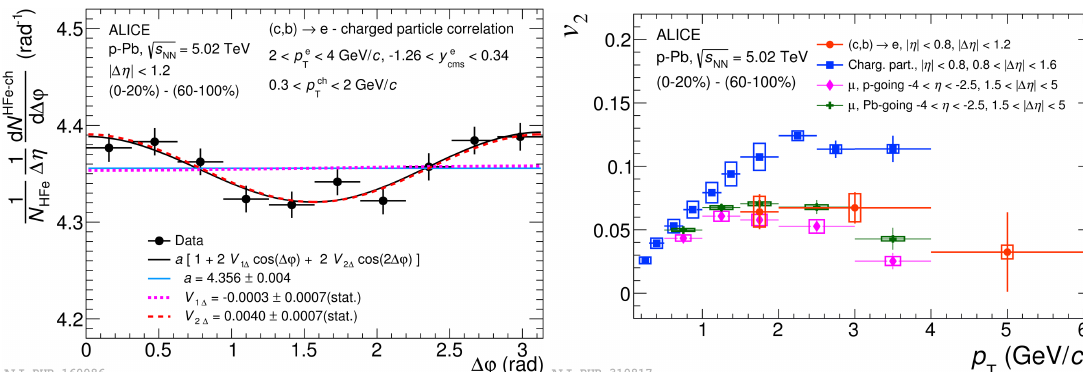
Figure 2. ( Left ): Azimuthal correlation distribution between heavy-flavour decay electrons and charged particles, for high-multiplicity p–Pb collisions after subtracting the jet contribution based on low-multiplicity collisions. The distribution is shown for 2 < p e GeV/c. The fit to the data points and its Fourier decomposition are also shown. ( Right ): heavy-flavour decay electron v 2 as a function of transverse momentum compared to the v 2 of unidentified charged particles [10] and inclusive muons